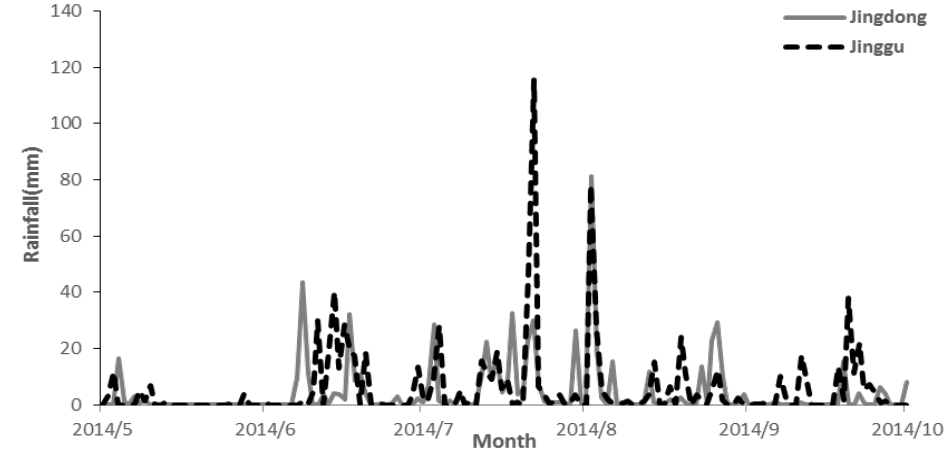
Figure 2. Rainfall curves of Jingdong and Jinggu during the flood season.